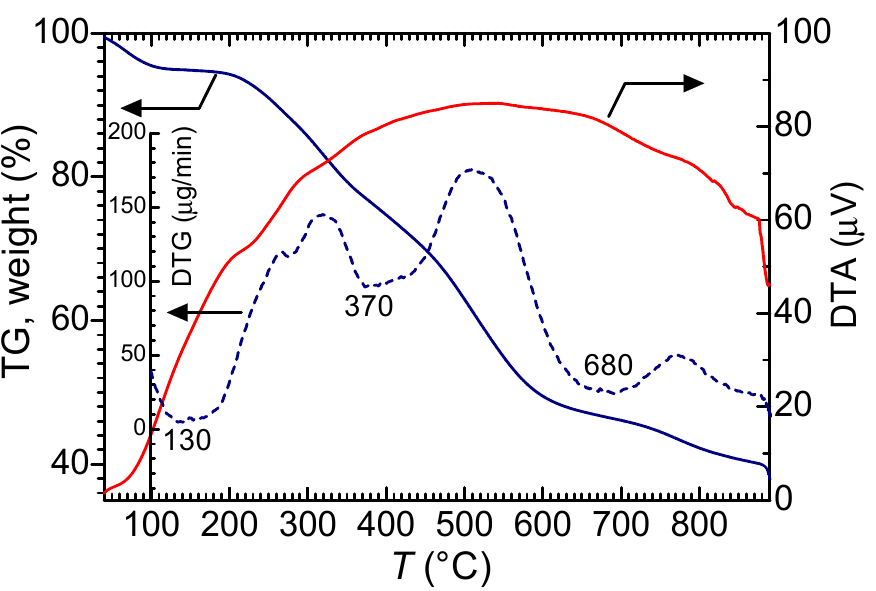
Figure 2. Thermogravimetric (TG) analysis, derivative thermogravimetric analysis (DTG), and differential thermal analysis (DTA) analysis of PANI-(+)-CSA.